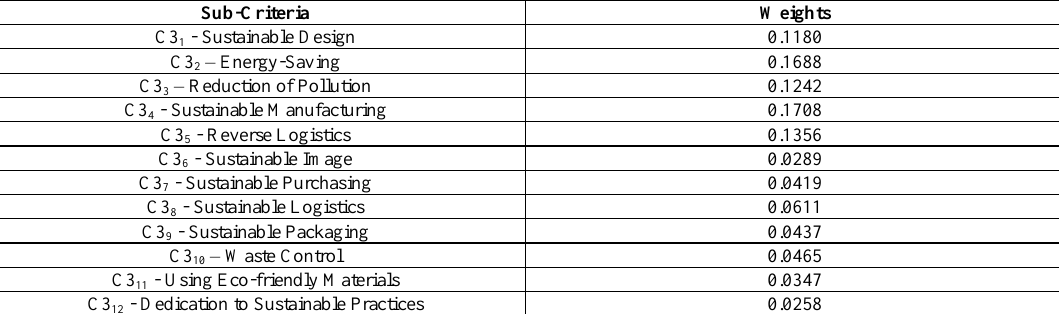
Table 5. Weights of sub-criteria within sustainable management systems cluster.